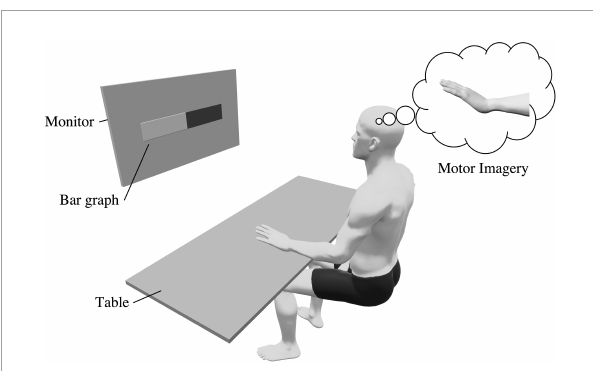
FIGURE2 Experimental setup. Participants were seated in a chair, placed their left hand on a desk, and imagined a kinesthetic wrist dorsiflexion movement. During the training phase, a bar graph was displayed on the monitor and the ERD was fed back to the